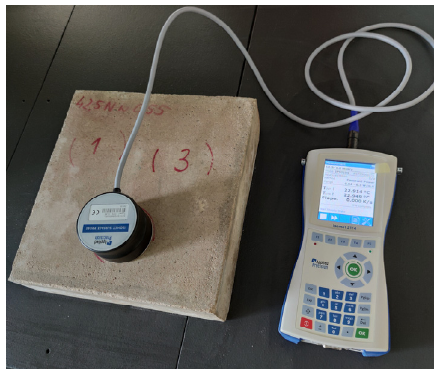
Figure 3. Thermal measurements test using the non-stationary heat flow method.